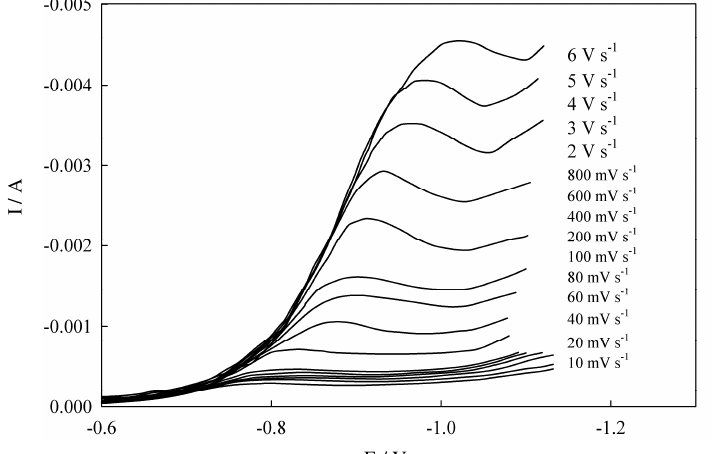
Figure 3. Typical series of voltammograms recorded on the lead electrode at different values of scan rate Chromium(III) methanesulphonate content is 0.005 M (green form) electrolyte contains 0.01 M